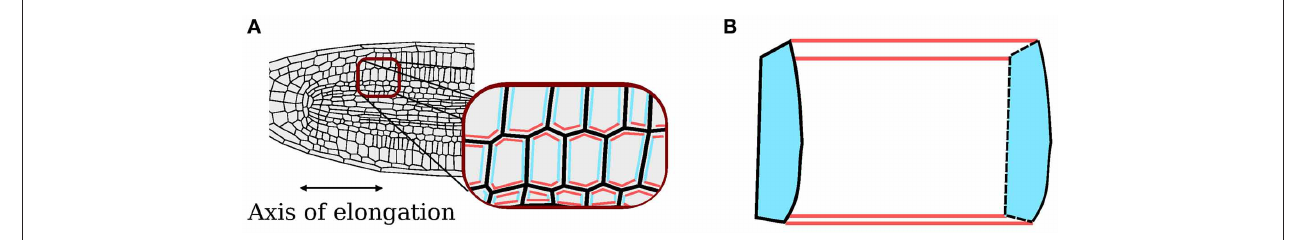
FIGURE 1 | Axial and cross walls. (A) Classification of cell walls perpendicular to the plane of the simulation as axial (red) and cross (blue); walls in the plane of the simulation are shaded gray. (B) Corresponding walls in the 3D organ.